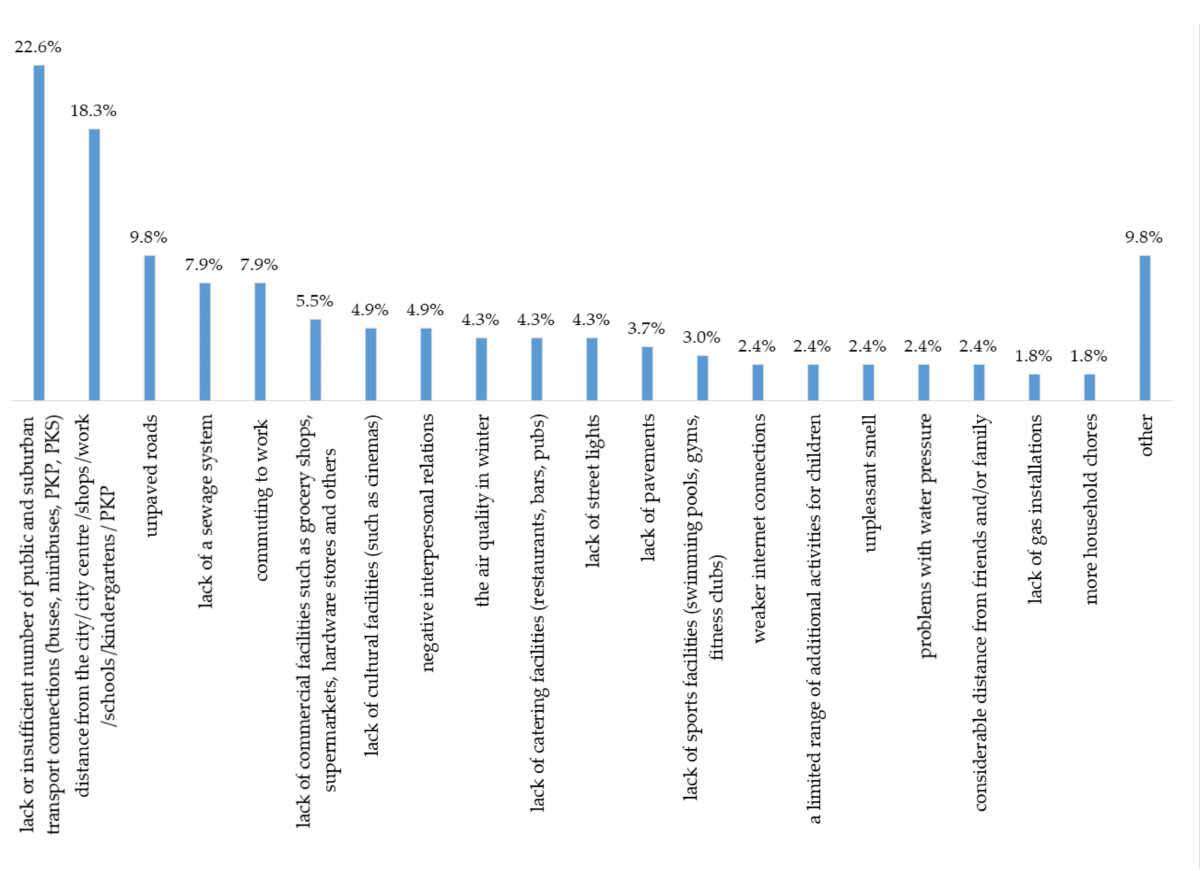
Figure 6. Elements of rural residence assessed negatively in relation to the previous place of residence. Source: own study based on research